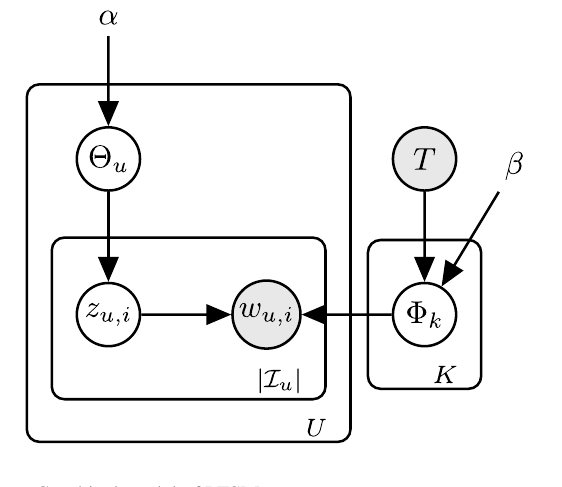
Fig. 1 Graphical model of